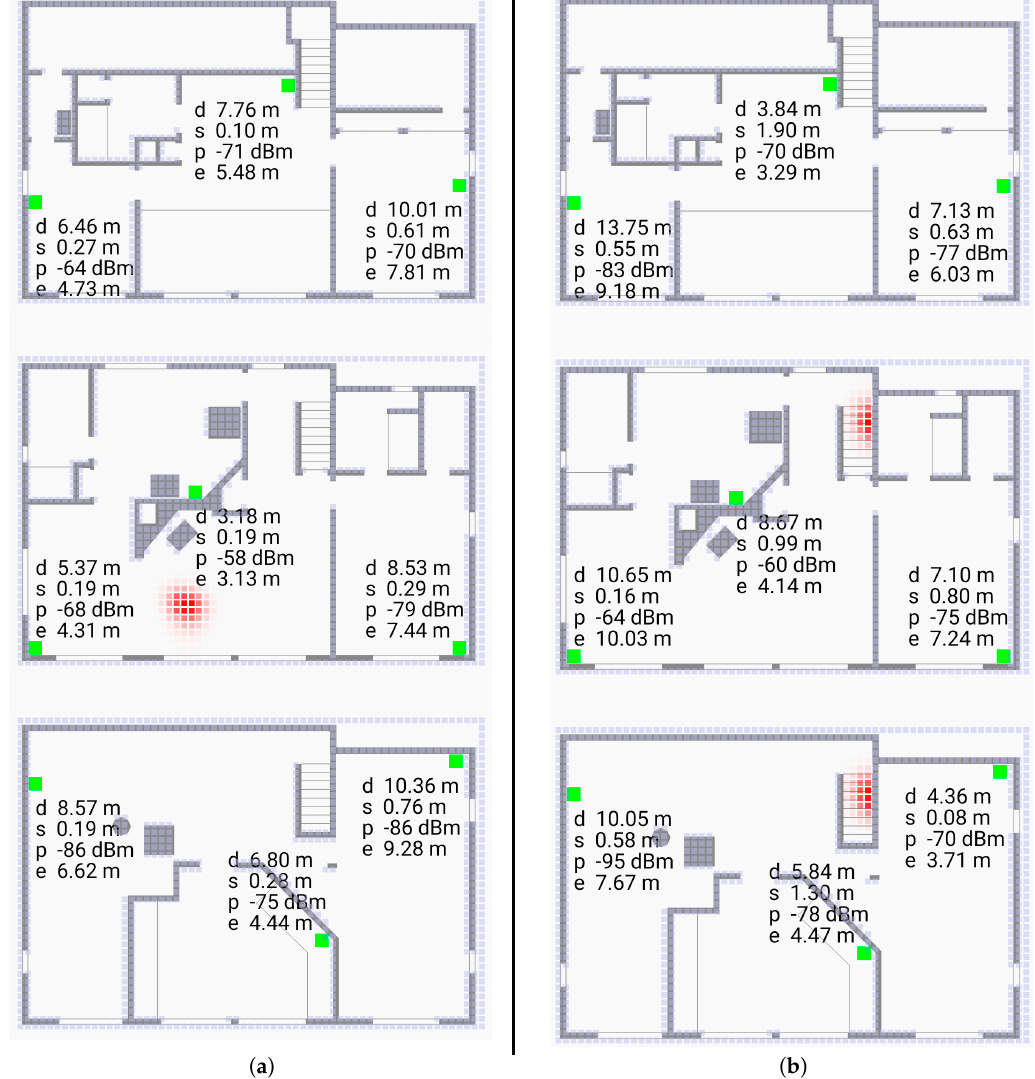
Figure 11. Screen shots of application using Bayesian grid update method as a “heat map” (from video [30]). The voxels are 0.2 m on a side. The green spots are the responders. ( a ) (left subfigure) initiator in middle of the middle floor ( b ) (right subfigure) initiator on stairs between floors. Note that the paths between initiator and responder in most cases pass through one or more walls or floors. The Bayesian grid update method uses the observation model developed